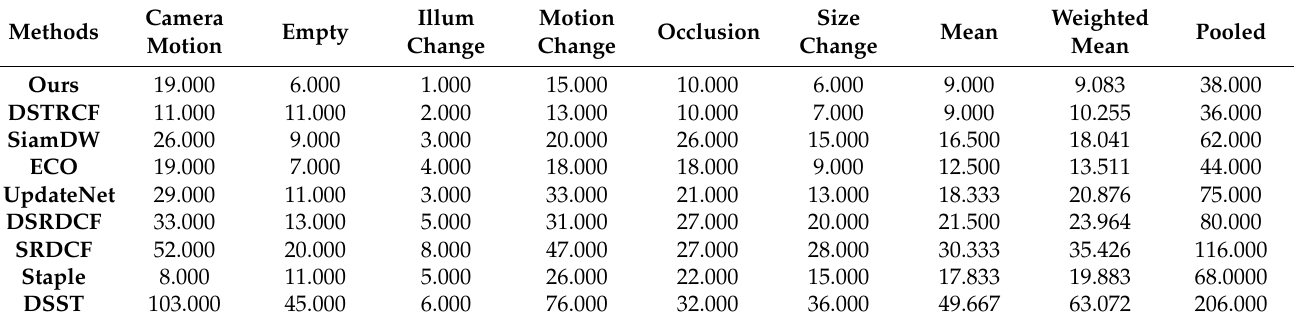
Table 3. Robustness results among all compared trackers evaluate on VOT2018.